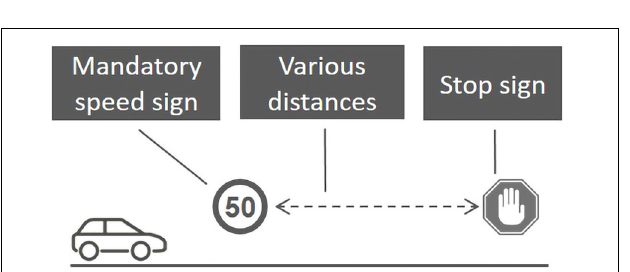
FIGURE 2 | The general layout of the experimental driving session. Experimental manipulations: mandatory speed sign (one of two speeds: 50 or 60 km/h) and STOP sign (at various distances: 15, 20, 25, 30, 35, or 40 m). Each participant performed the driving sessions under all combinations of speeds and braking distances at random